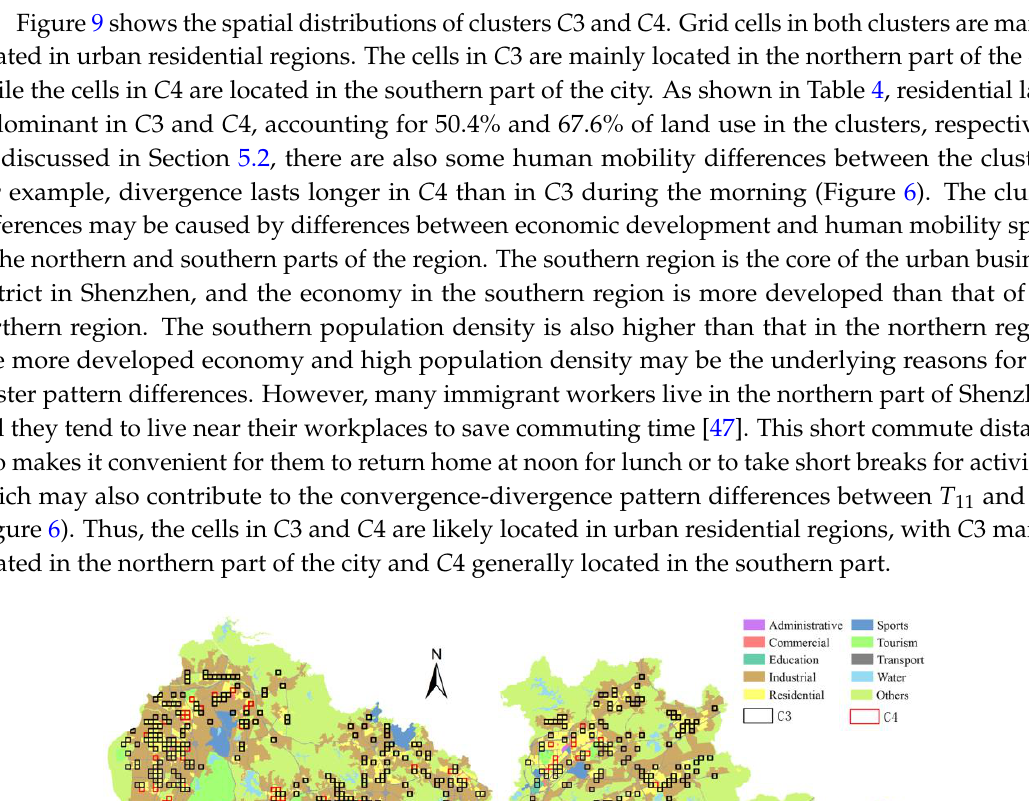
Figure 8. Spatial distributions of identified functional clusters C 2 and C 5.